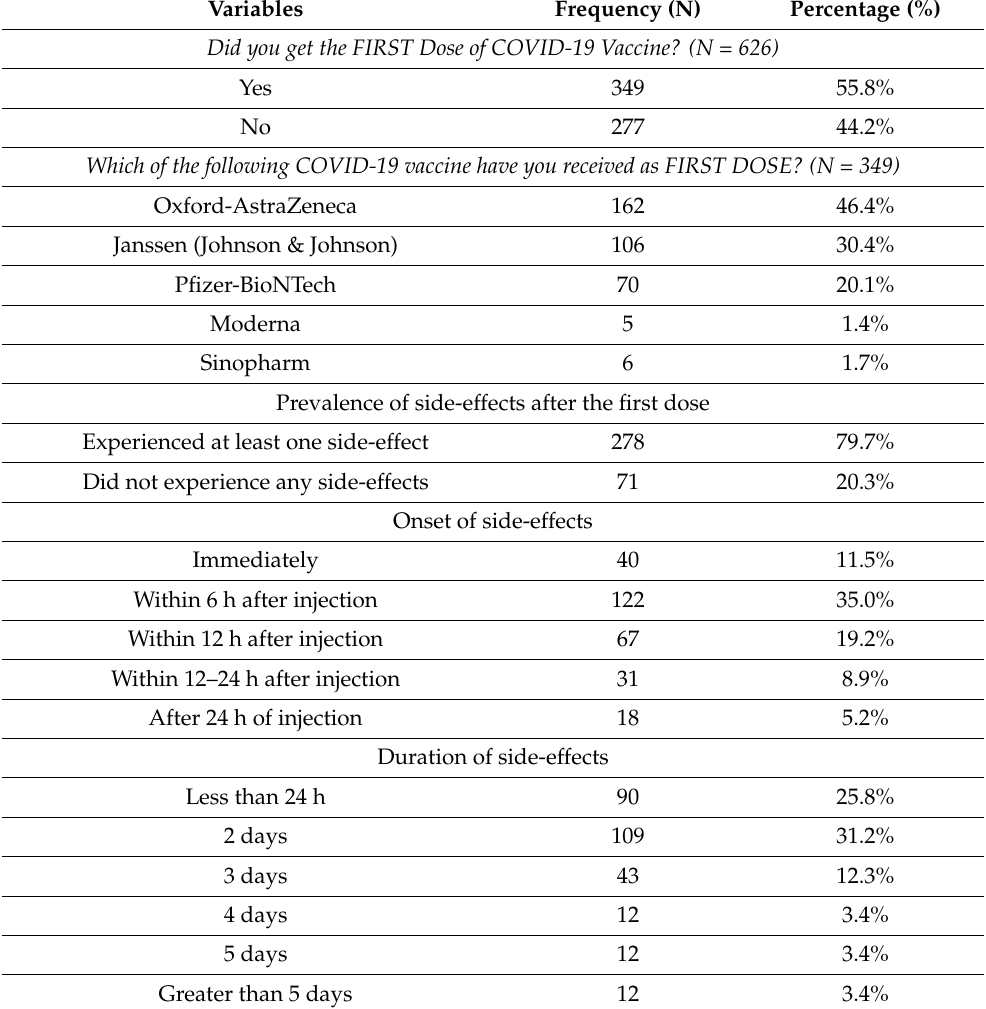
Table 2. Participants receiving the first dose of COVID-19 vaccines.